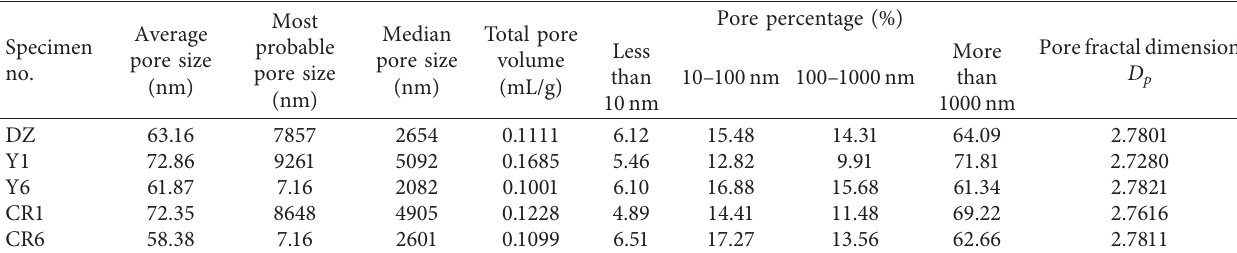
Table 4: Pore structure